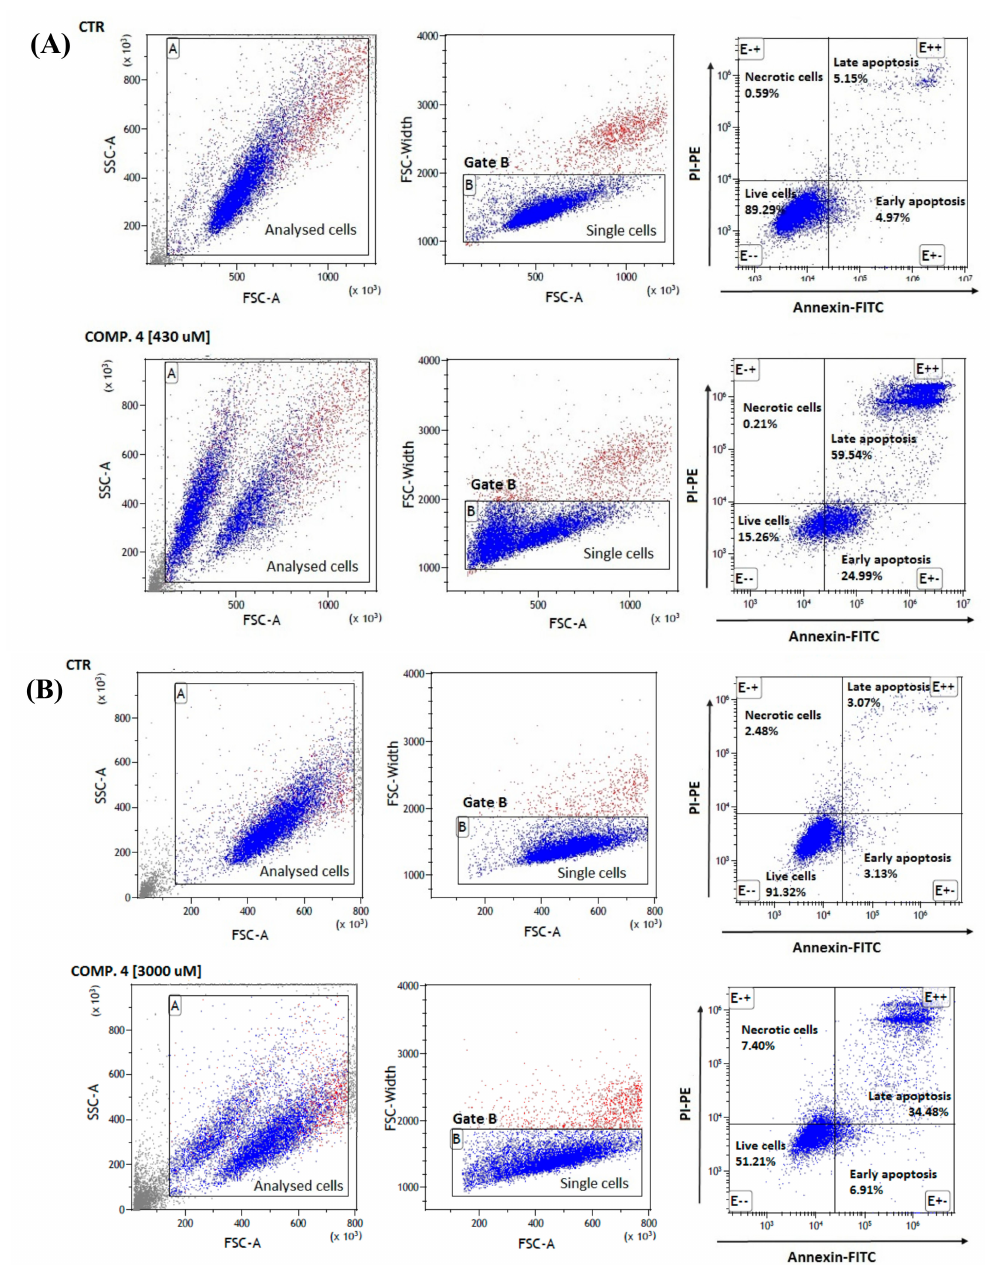
Figure 7. The e ff ects of compound 4 on MCF-7 ( A ) and MDA-MB-231 ( B ) cells’ viability and apoptosis. The cytograms in the upper line are representatives for control cells; the cytograms in the lower line are representatives for compound 4 . Cytograms on the left side—forward and side scatter plot of MCF-7 cells. The cells were marked with gate A (the events not enclosed with the gate are smaller and might constitute some parts of broken cells (cell debris)). Cytograms in the centre—a forward scatter width (FSC-W) vs. forward scatter area (FSC-A) of the cells gathered in gate A. Based on FSC-A parameters, single cells were divided (in the lower parts of the cytogram) and marked with gate B. The single cells in gate B were analyzed for staining with annexin V and propidine iodide. Cytograms on the right side—annexin V (x-axis) vs. propidium iodide (y-axis) plots from the gated cells (B) show the populations corresponding to living cells (annexin V ( − ) and PI ( − )) (E −− )—lower-left square, early-apoptotic cells (annexin V ( + ) and PI ( − )) (E + − )—lower-right square, late-apoptotic cells (annexin V ( + ) and PI ( + )) (E ++ )—upper-right square and necrotic cells (annexin V ( − ) and PI ( + )) (E − + )—upper-left